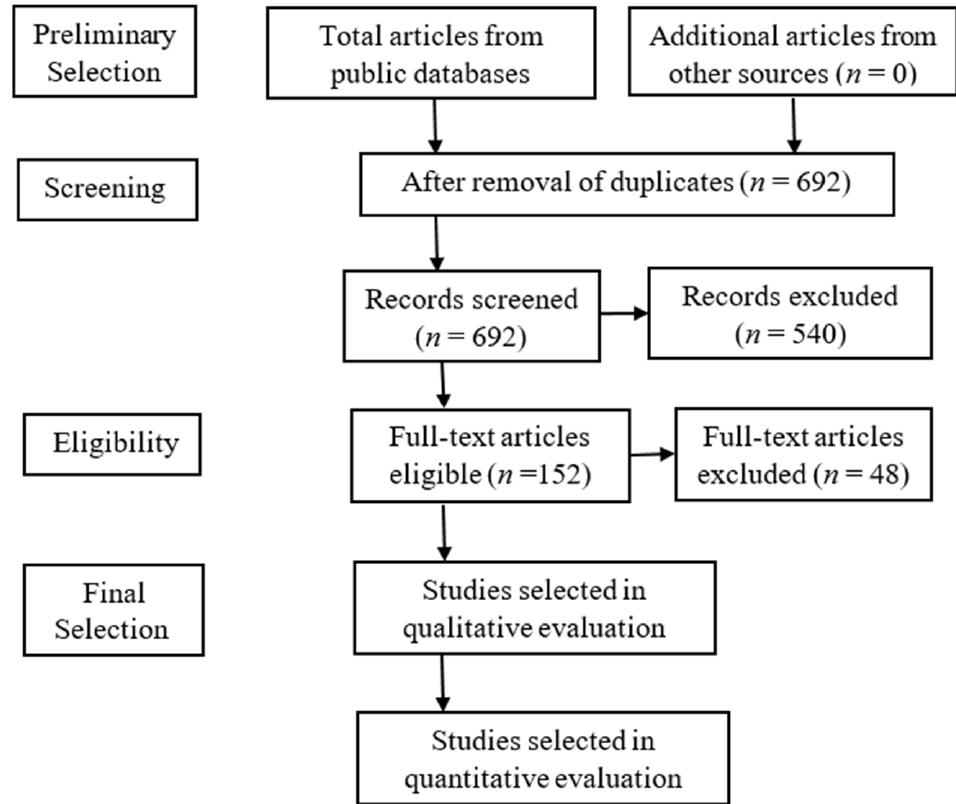
Figure 5. Block diagram of selection criteria by PRISMA guidelines for the